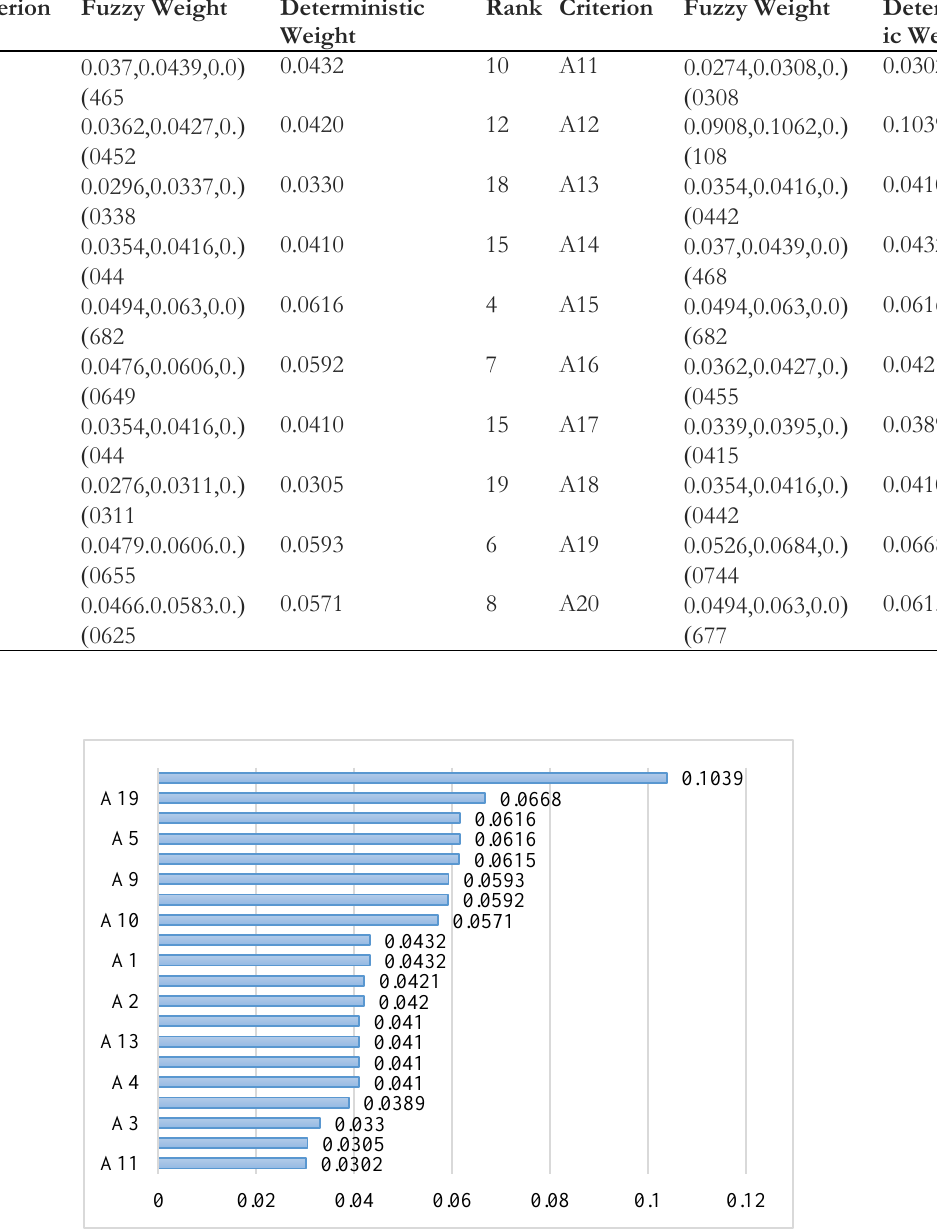
Fig. 1. Weights of legal